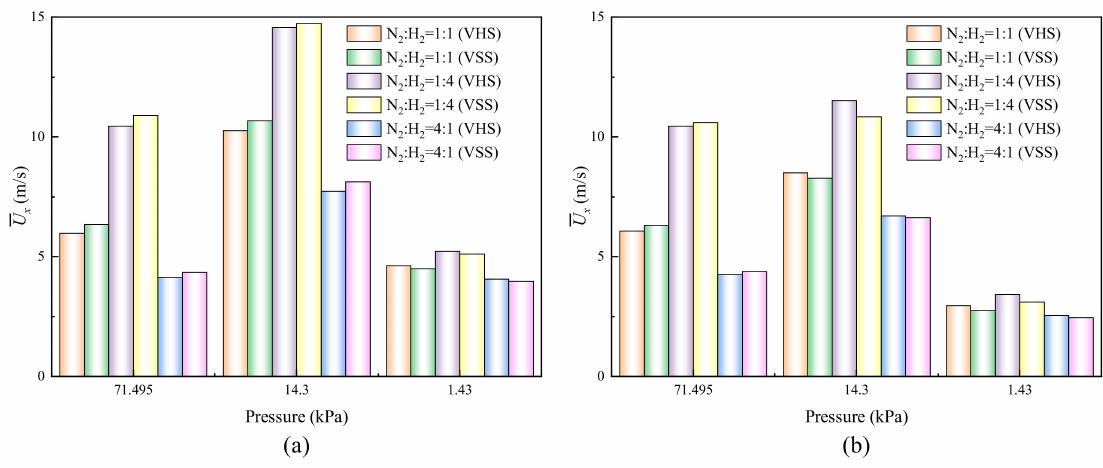
Figure 6. Mean velocities over an x = 2 µ m vertical line for di ff erent pressures. ( a ) Mean velocities of H 2 . ( b ) Mean velocities of N 2